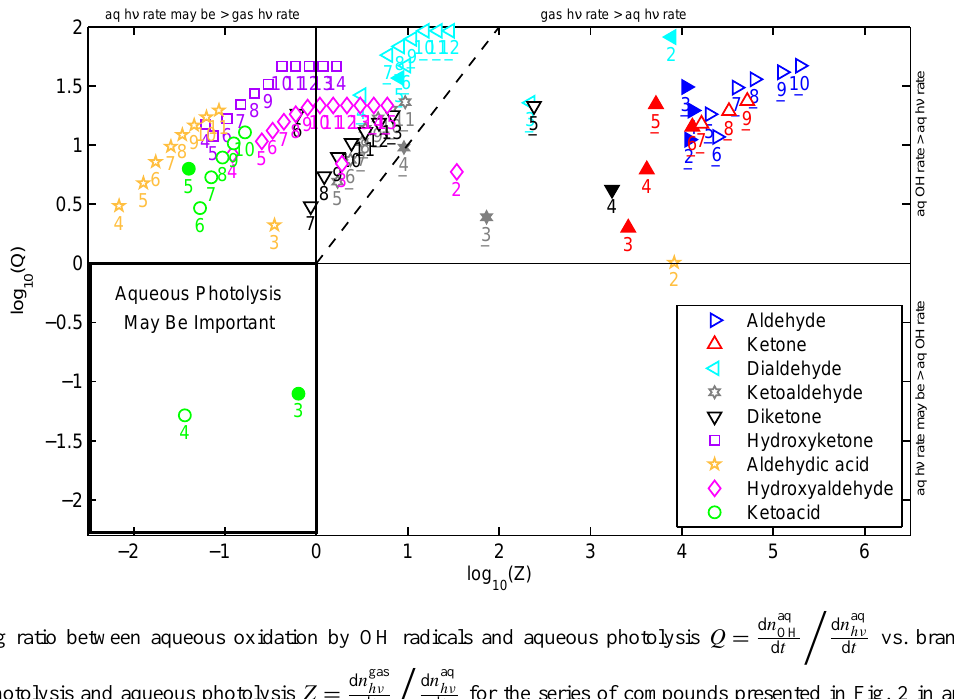
Fig. 6. Branching ratio between aqueous oxidation by OH radicals and aqueous photolysis Q = tween gaseous photolysis and aqueous photolysis Z = LWC=0.5gm − 3 , an aqueous OH concentration of 10 − 13 M at a solar zenith angle of 20 ◦ . All aqueous photolysis quantum yields are as- sumed to be at their upper limit ( 8 =1). Molecules notated with filled markers indicate that published λ max and ε max values were used to calculate extinction coefficients. Open markers indicate that extinction coefficients were determined with estimations of λ max and ε max from compounds with similar functional groups. Numbers corresponding to each symbol indicate the number of carbon molecules in the chain. Underlined numbers indicate that gas-phase oxidation by OH is the dominant removal mechanism. Rate constants, hydration equilibrium constants, Henry’s law constants, structures, names, and all corresponding references are presented in the SM Sect. 19. The Q = Z line is shown as a dashed line in the upper-right